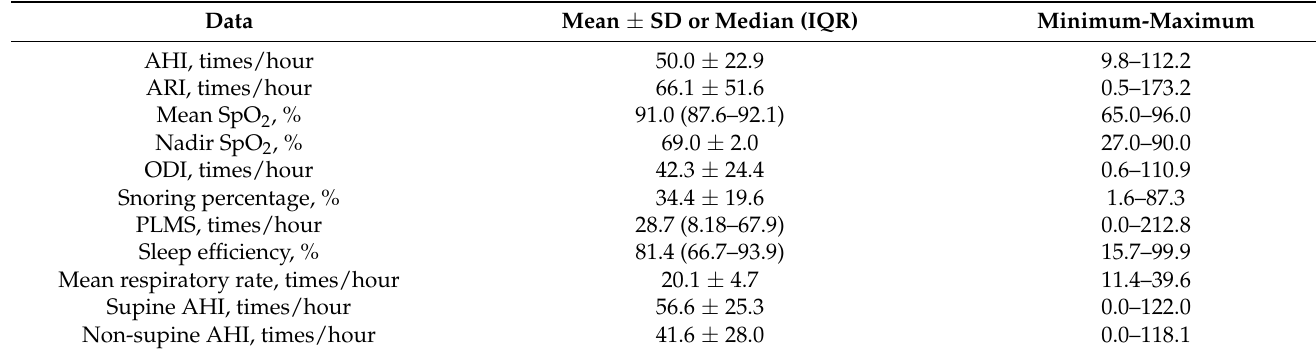
Table 2. Polysomnographic data before